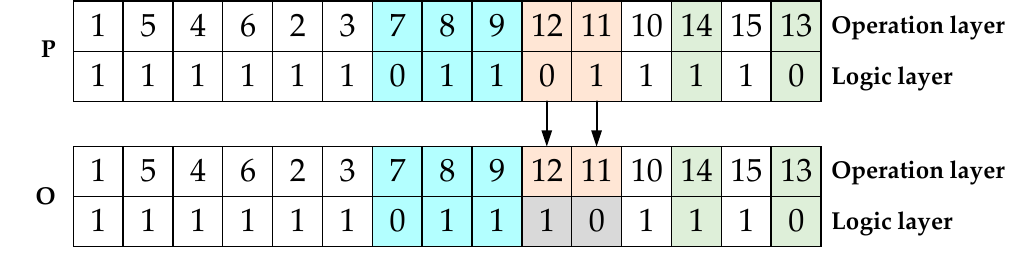
Figure 13. The AND/OR network of the product in case 1.